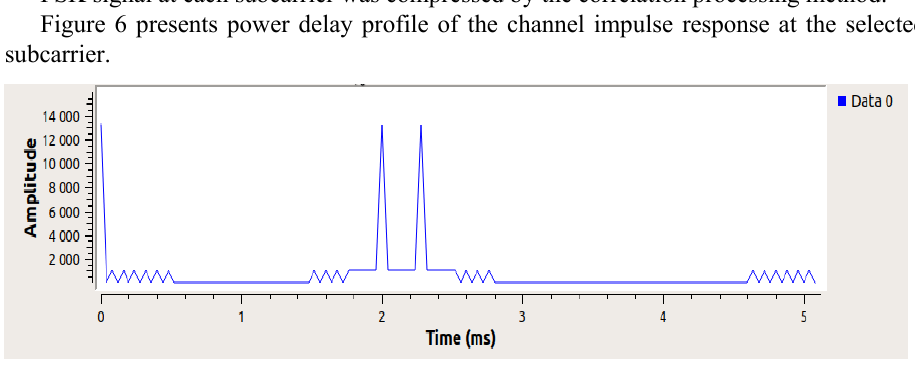
Fig. 5. Received subcarrier of the OFDM signal with BPSK (direct signal and 2 delayed signals). PSK signal at each subcarrier was compressed by the correlation processing method.